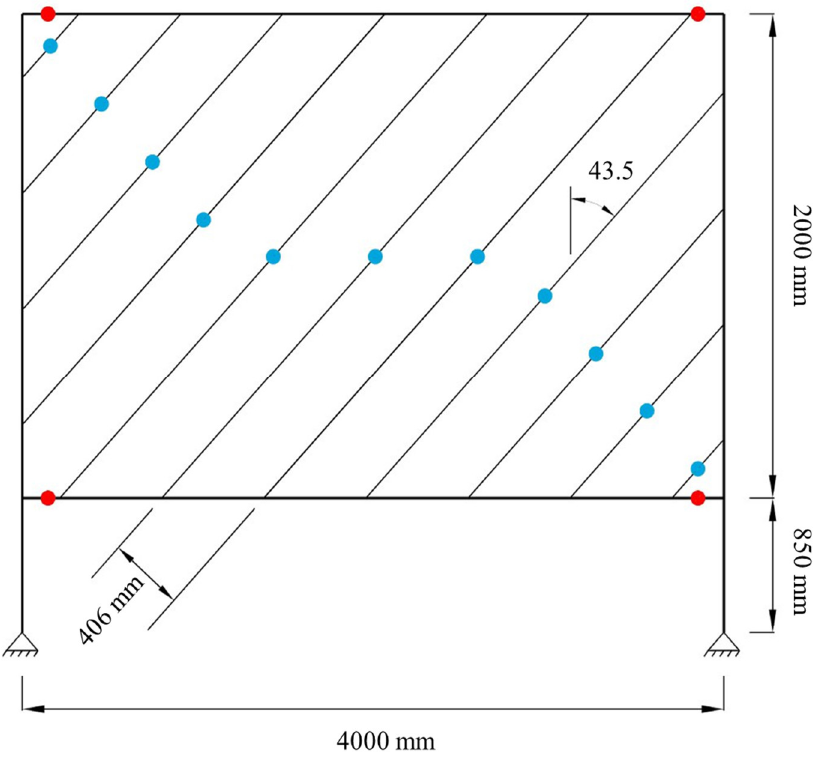
Figure 6. Tension strip layout for the modeling of the SPSW developed by Vian et al. [32].